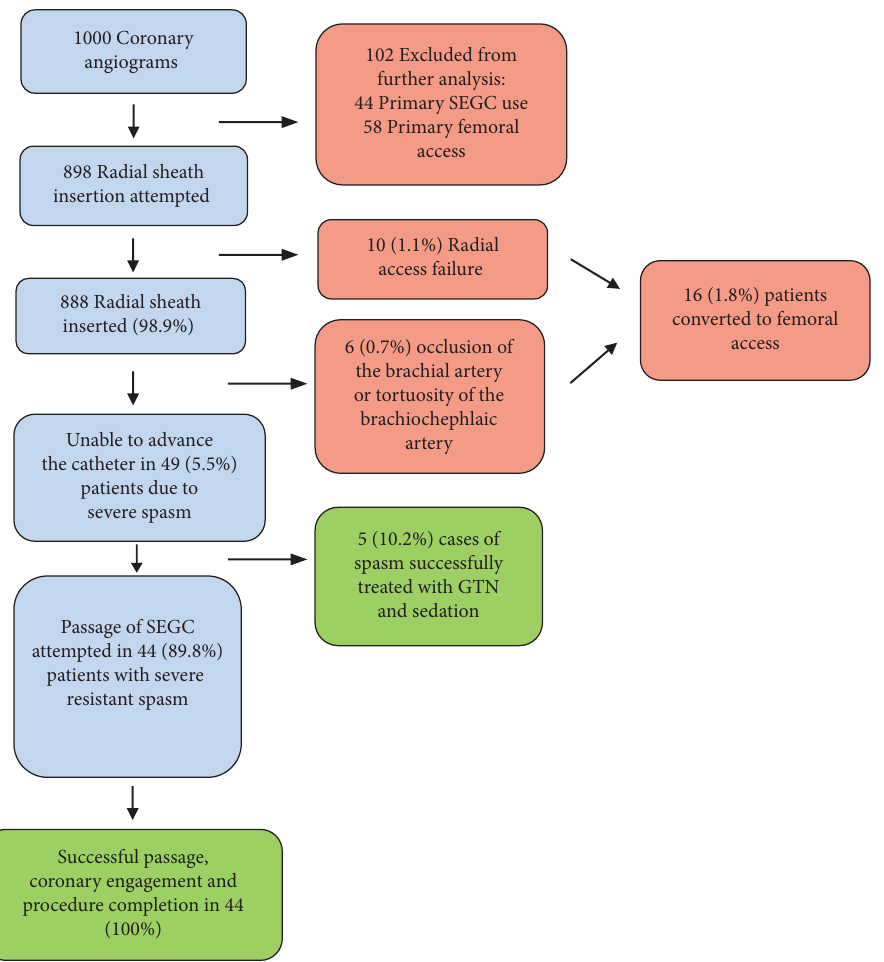
Figure 1: Study fow